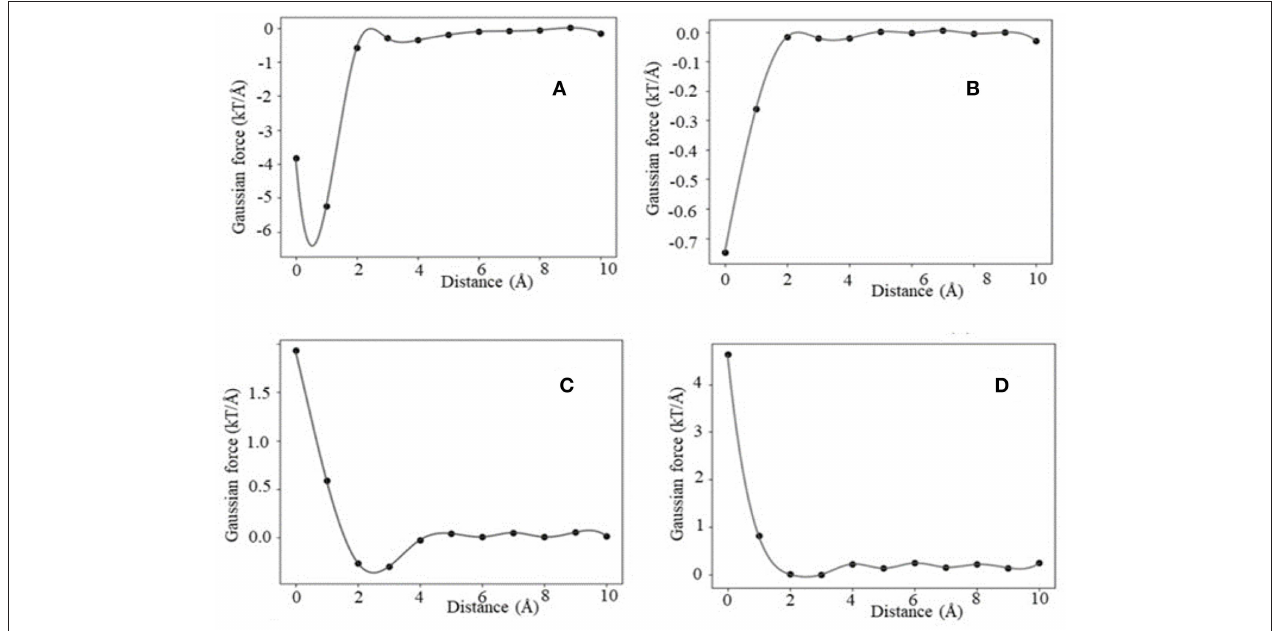
FIGURE 4 | Representative example of F int profiles obtained using the Gaussian-based dielectric model: (A) maximum attraction force at a particular distance, (B) distance maximum attraction force at bound state, (C) soft landing, and (D) repulsive